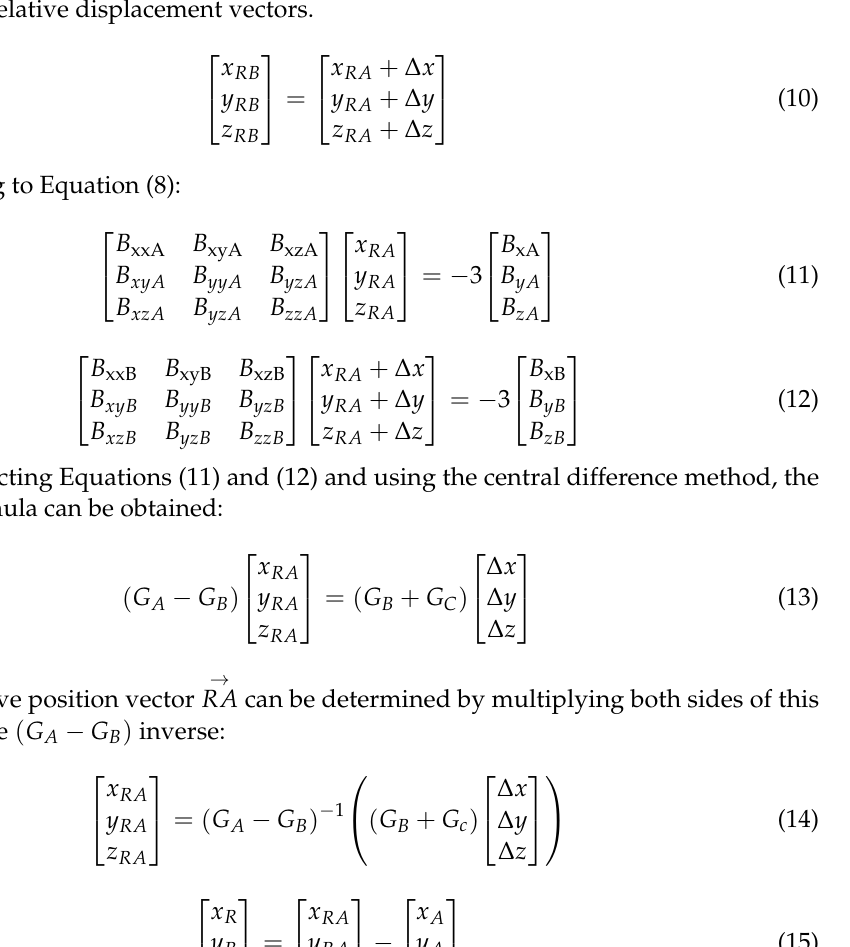
  → → x , y , z ) and RB x , y , ( ( RB ( x RB , y RB , z RB ) RA ( x RA , y RA , z RA ) and RA RA RA RB RB